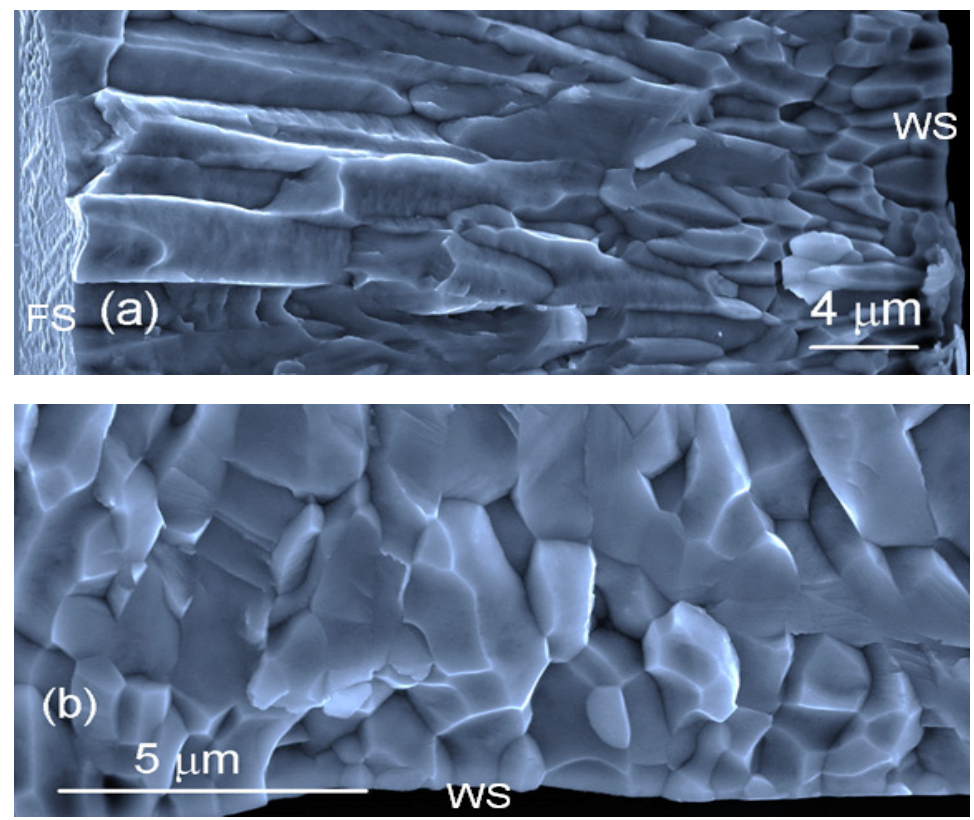
Figure 3. SEM image of the fracture surface of the ribbon. ( a ) The long columnar crystals grow from the wheel side (WS) of the ribbon towards its free surface (FS). ( b ) The small grains developed at the wheel side of the ribbon.